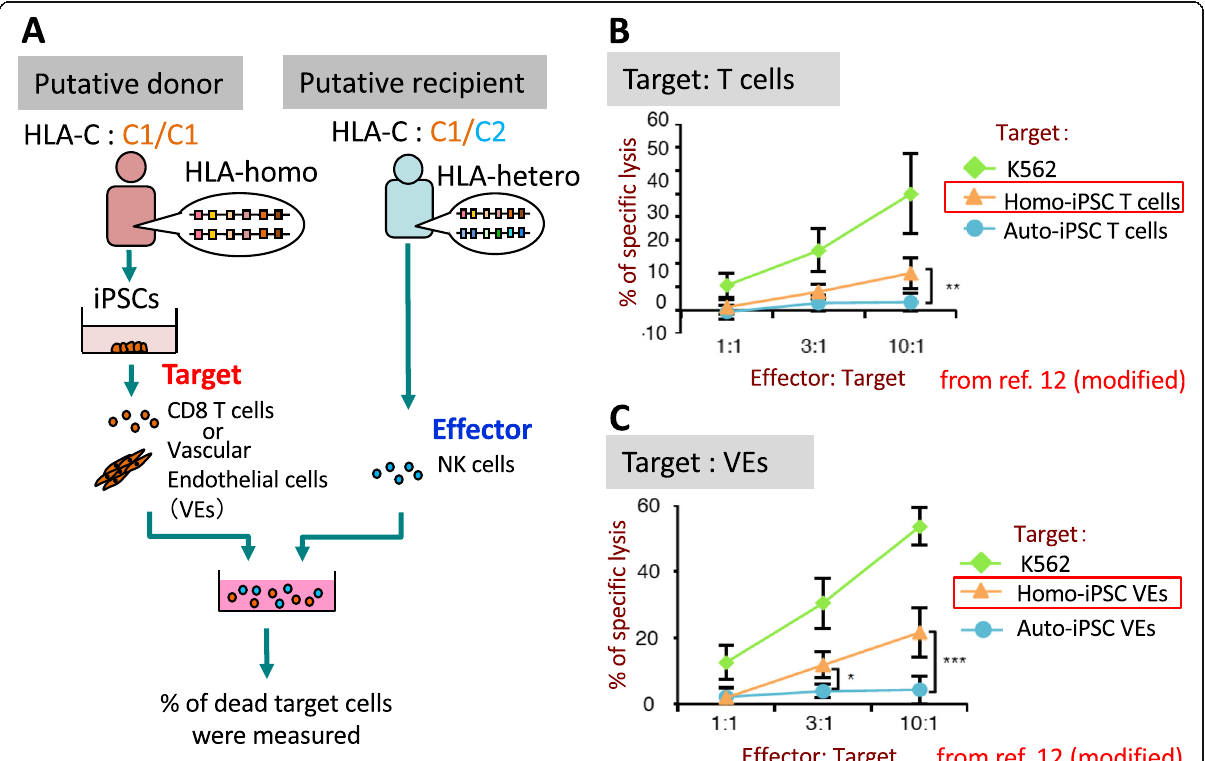
Fig. 3 Cytotoxic activity mediated by NK cells in the homo-to-hetero transplantation setting. a Schematic illustration of the experimental design. iPSCs were established from an HLA-haplotype homozygous individual as a putative donor and from an HLA-haplotype heterozygous person who carried HLA-C1 and HLA-C2 epitopes as a putative recipient. As target cells, T cells or vascular endothelial cells (VEs) were differentiated from these iPSCs. As effector cells, NK cells collected from peripheral blood mononuclear cells of a putative recipient were used. After effector and target cells were co-cultured for 6 h (T cells) or 18 h (VEs) in different E:T ratio ’ s, the percentage of dead target cells were measured by Cr 51 - release assay. b Cytotoxicity assay of NK cells isolated from the putative recipient against HLA-homo-derived T cells. ** p < 0.01, Student ’ s t test. c Cytotoxicity assay of NK cells isolated from the putative recipient against HLA-homo-derived VEs. * p < 0.05, *** p < 0.001, Student ’ s t